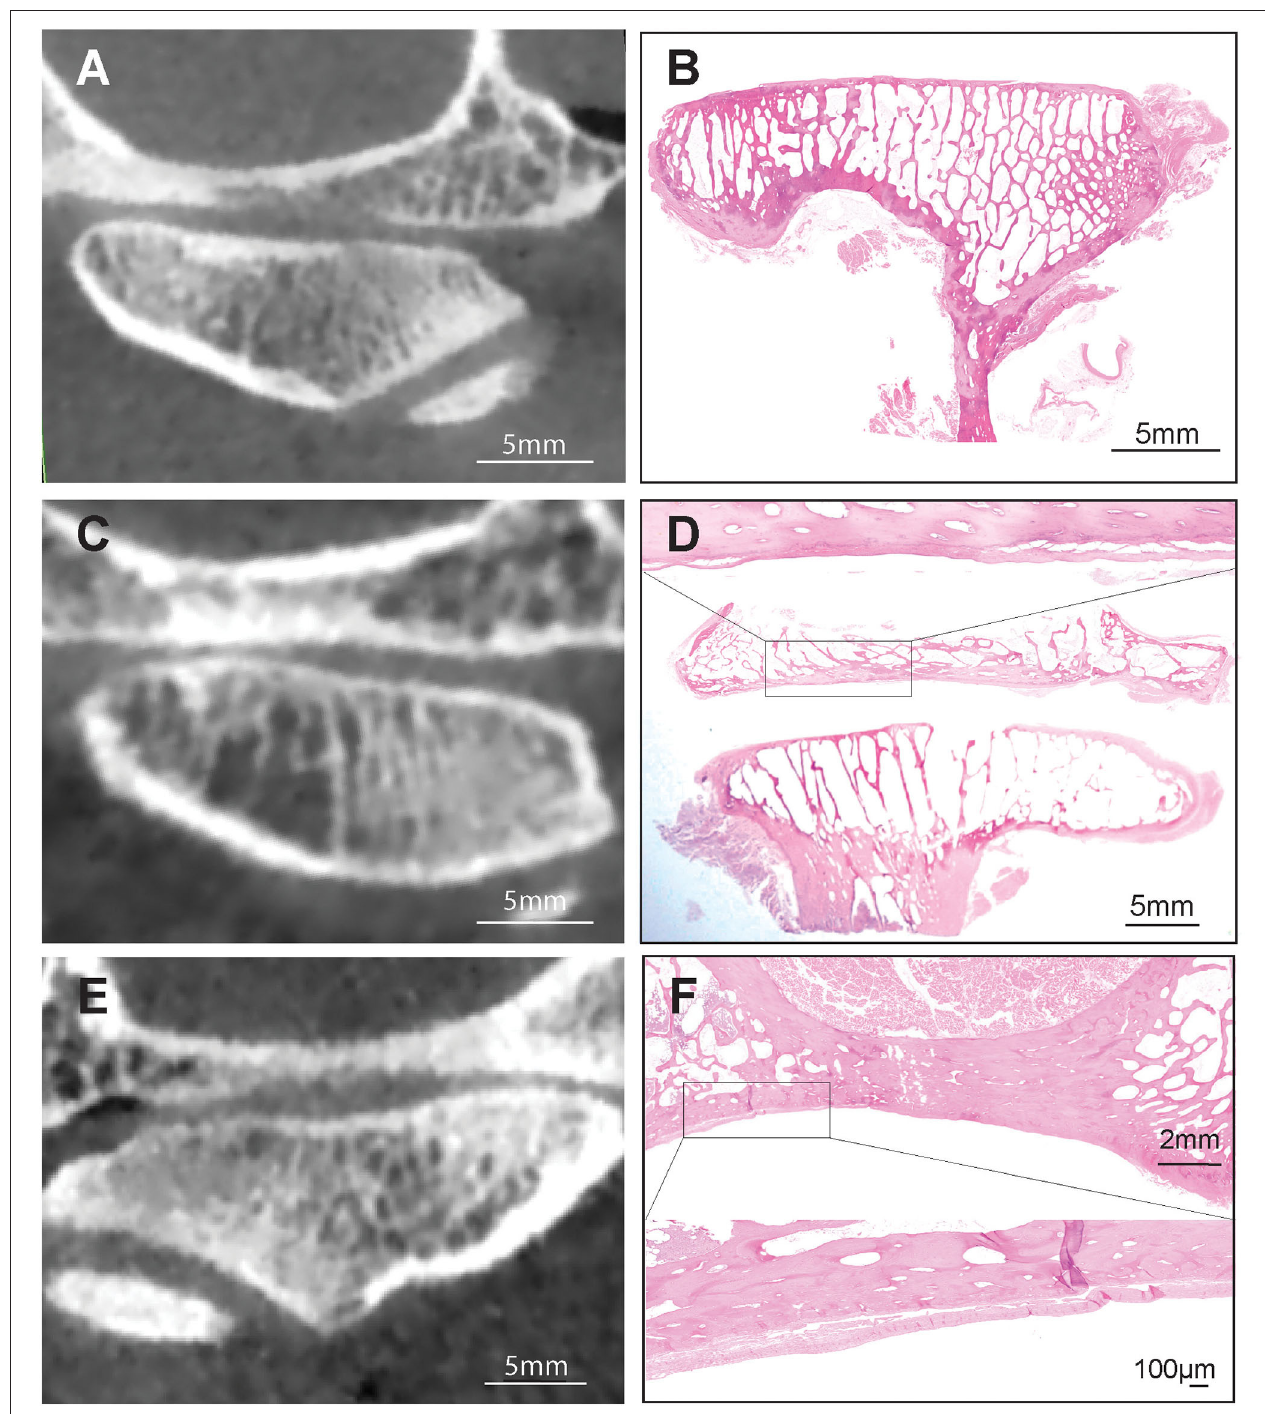
FIGURE 5 | Series of CBCT and histological images demonstrating the fair to moderate agreement between CBCT and histology on subchondral bone sclerosis (A,B) , between joint space narrowing and articular cartilage damage (C,D) and subchondral bone erosion (E,F) . Hematoxilin & Eosin staining, Bar = 5mm and closeup Bar = 100 µ